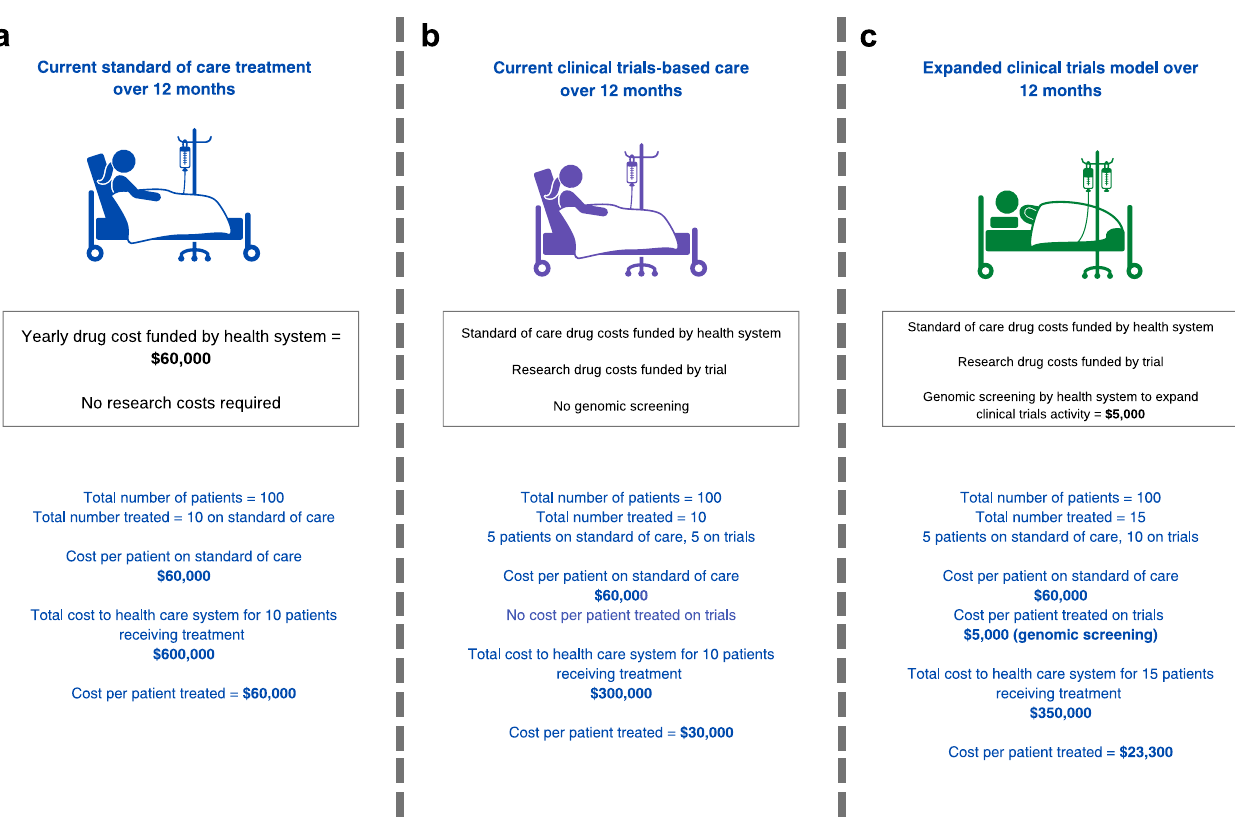
Fig. 2 Genomic screening and cancer treatment in health systems and clinical trial cost-offsets. ©[Leremy Gan] via Canva.com. a : current standard of care treatment; b : clinical trials-based care; c : expanded clinical trials supported by population-level